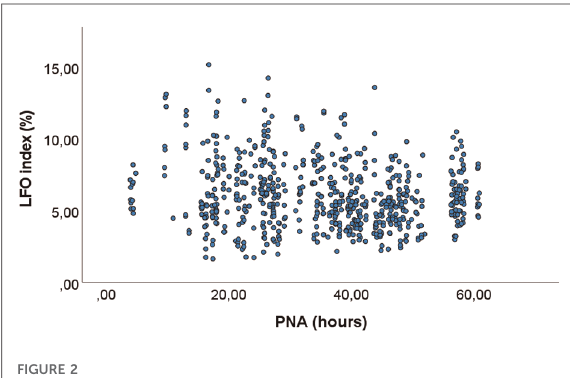
FIGURE 2 The relationship between arterial low frequency oscillations and postnatal age. The arterial low frequency oscillations (LFO) index ( y -axis) is plotted against postnatal age (PNA) ( x